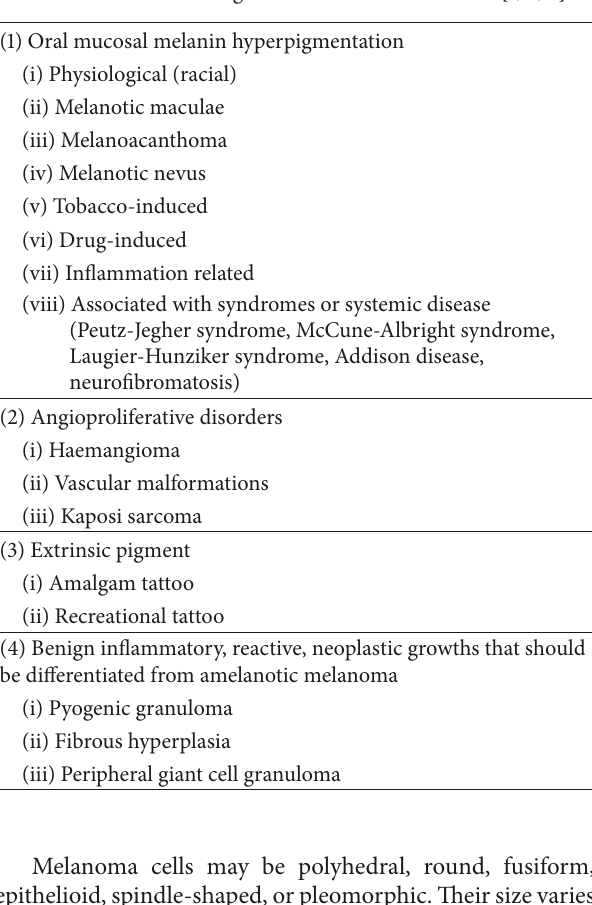
Table 1: Differential diagnoses of mucosal melanoma [1, 6,